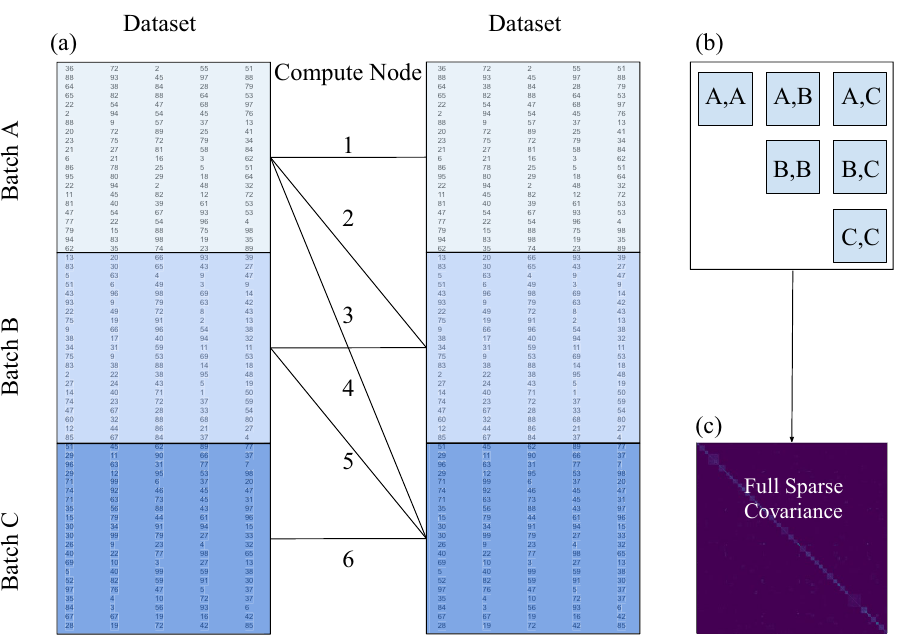
Figure 4. Figure illustrating the computational building block of the proposed algorithm. The dataset is divided into batches (panel a ). Pairs of batches are sent to the compute nodes where the associated sub-matrices of the covariance matrix are calculated using the presented sparse kernels (Eq. (10), panel b ). The sub-matrices are cast into a sparse format on the compute nodes before being sent back to the host. There, they get assembled to obtain the full sparse master covariance matrix (panel c ). All subsequent mathematical operations needed for a GP, namely calculating the log-determinant and solving a linear system, are performed efficiently on the sparse covariance